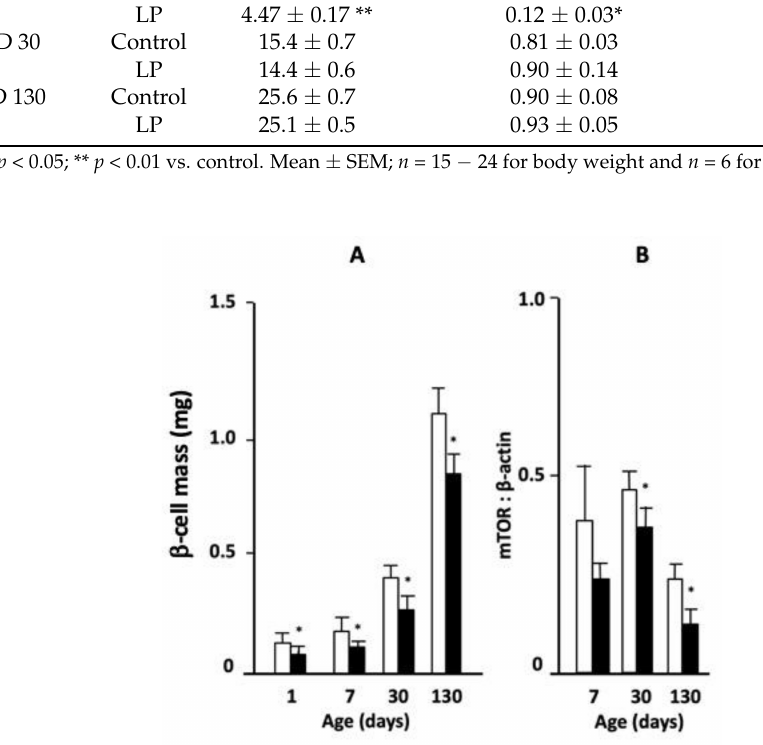
Figure 1. ( A ) Changes in β -cell mass in offspring from control (open bars) or low-protein (LP) diet (closed bars)-fed mice at 1, 7, 30 or 130 days of age, and ( B ) abundance of mammalian target of rapamycin (mTOR) protein in isolated islets relative to β -actin at 7, 30 and 130 days (Mean ± standard error of the mean (SEM); * p < 0.05 vs. control, n =